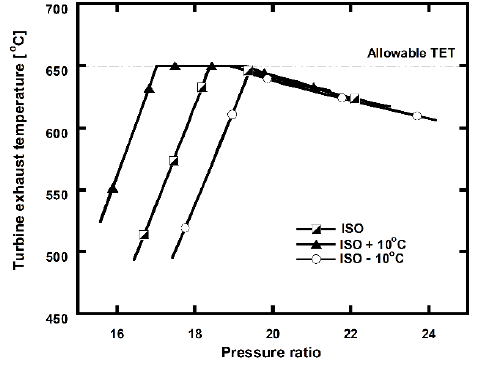
Figure 7. The control curve for the conventional schedule-based control.